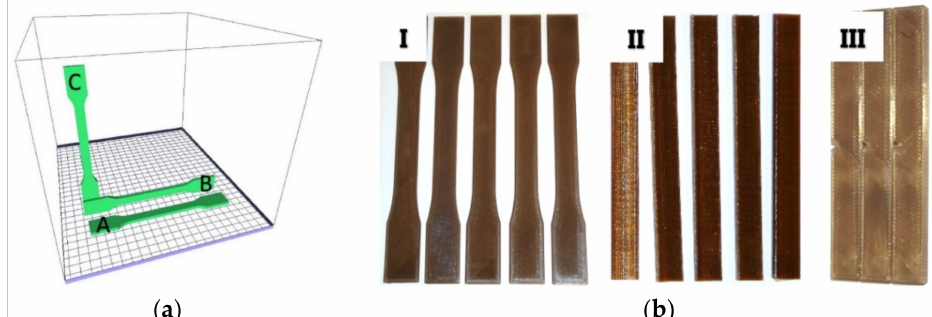
Figure 1. ( a ) Geometric orientation of the printed samples with the marked printing directions:(A) through thickness, (B) transverse, (C) longitudinal; ( b ) printed specimens used for: I—tensile testing, II—three-point bending testing, III— impact